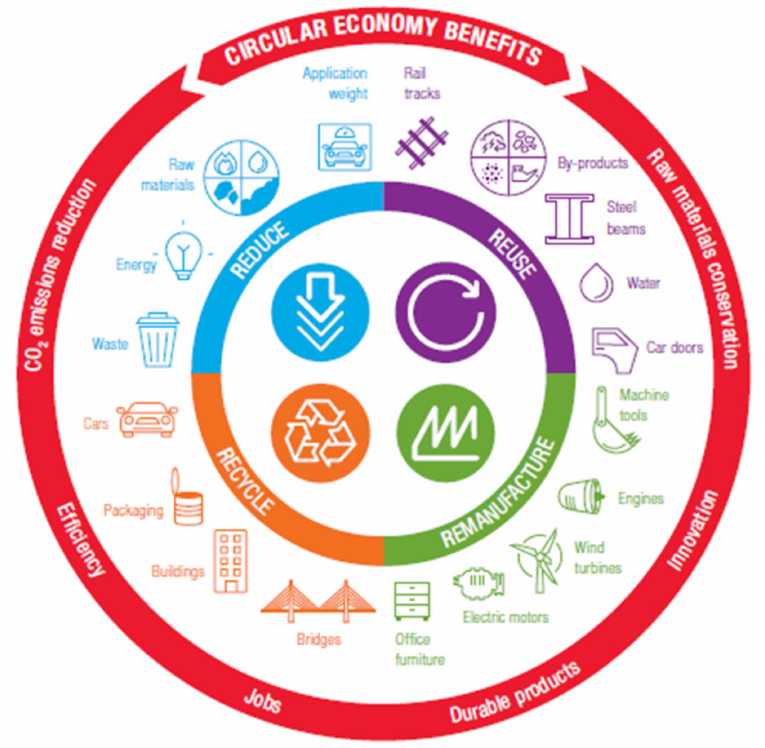
Figure 16. Steel in the circular economy: the 4 R’s